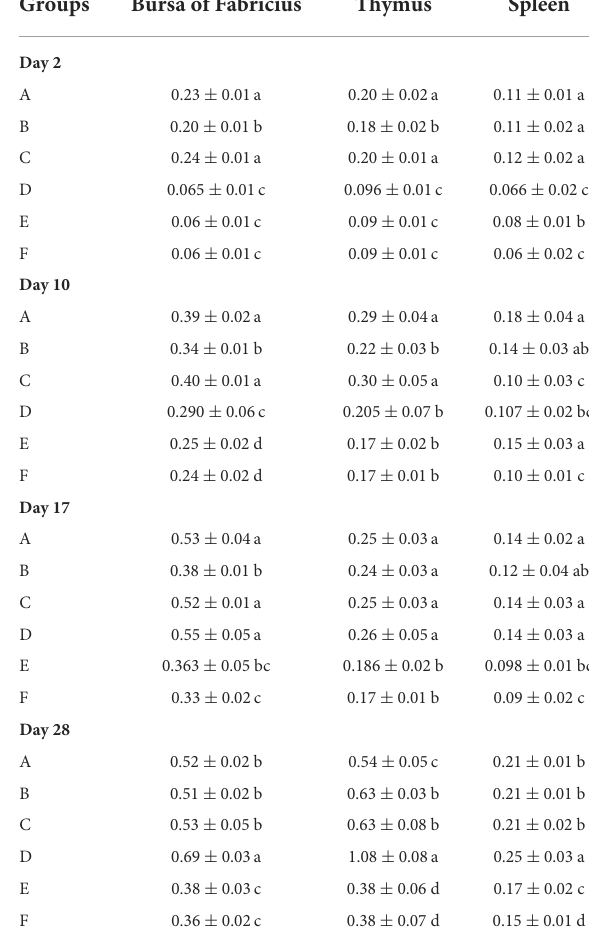
TABLE 6 Absolute organ weights (mean ± SD) of the White Leghorn chicks administered live IBD vaccines in ovo and post-hatch. Groups